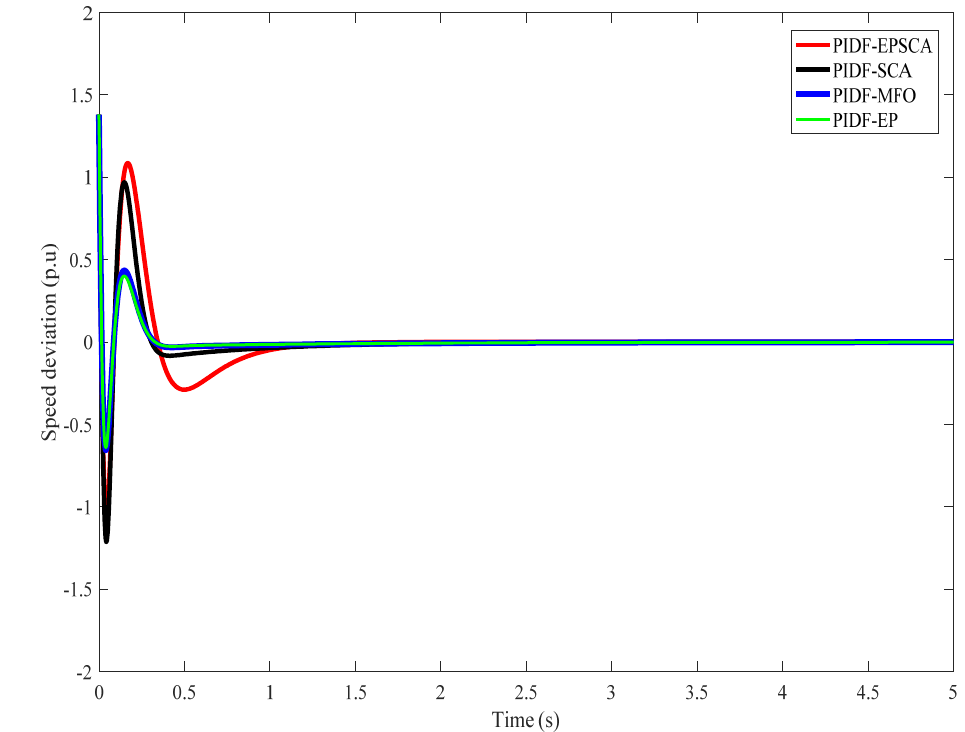
Figure 16. Speed deviation response of the TCSC-PIDF controller using PIDF-EPSCA, PIDF-SCA, PIDF-MFO, and PIDF-EP techniques for Scenario A-1.